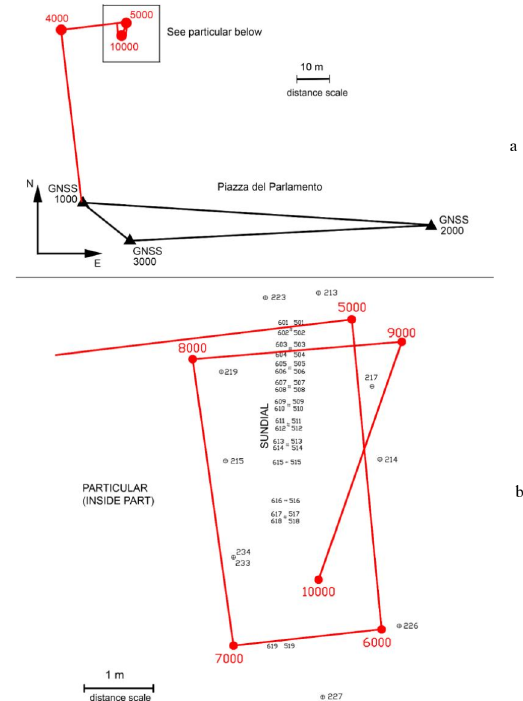
Figure 2. Topographic three-dimensional (3D) network: general layout ( a ) and detail of the internal / underground part ( b